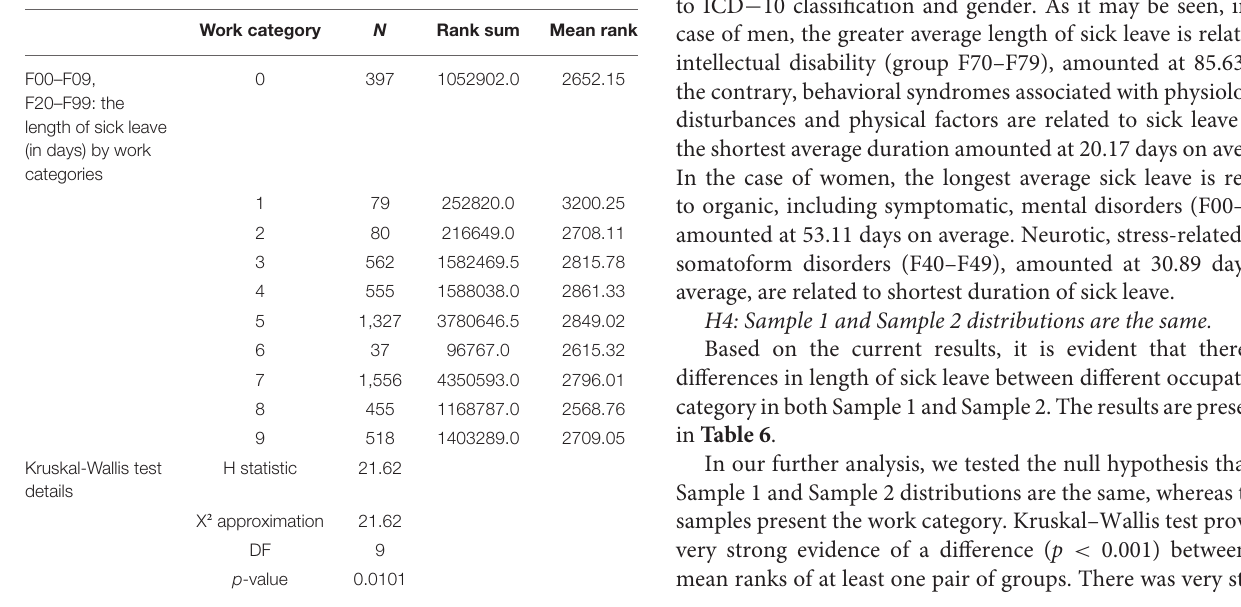
TABLE 4 | Kruskal–Wallis test results: the length of sick leave related to mental illnesses caused by other conditions, in the study sample of young adults aged 15–29 years, the Czech Republic, 2017.